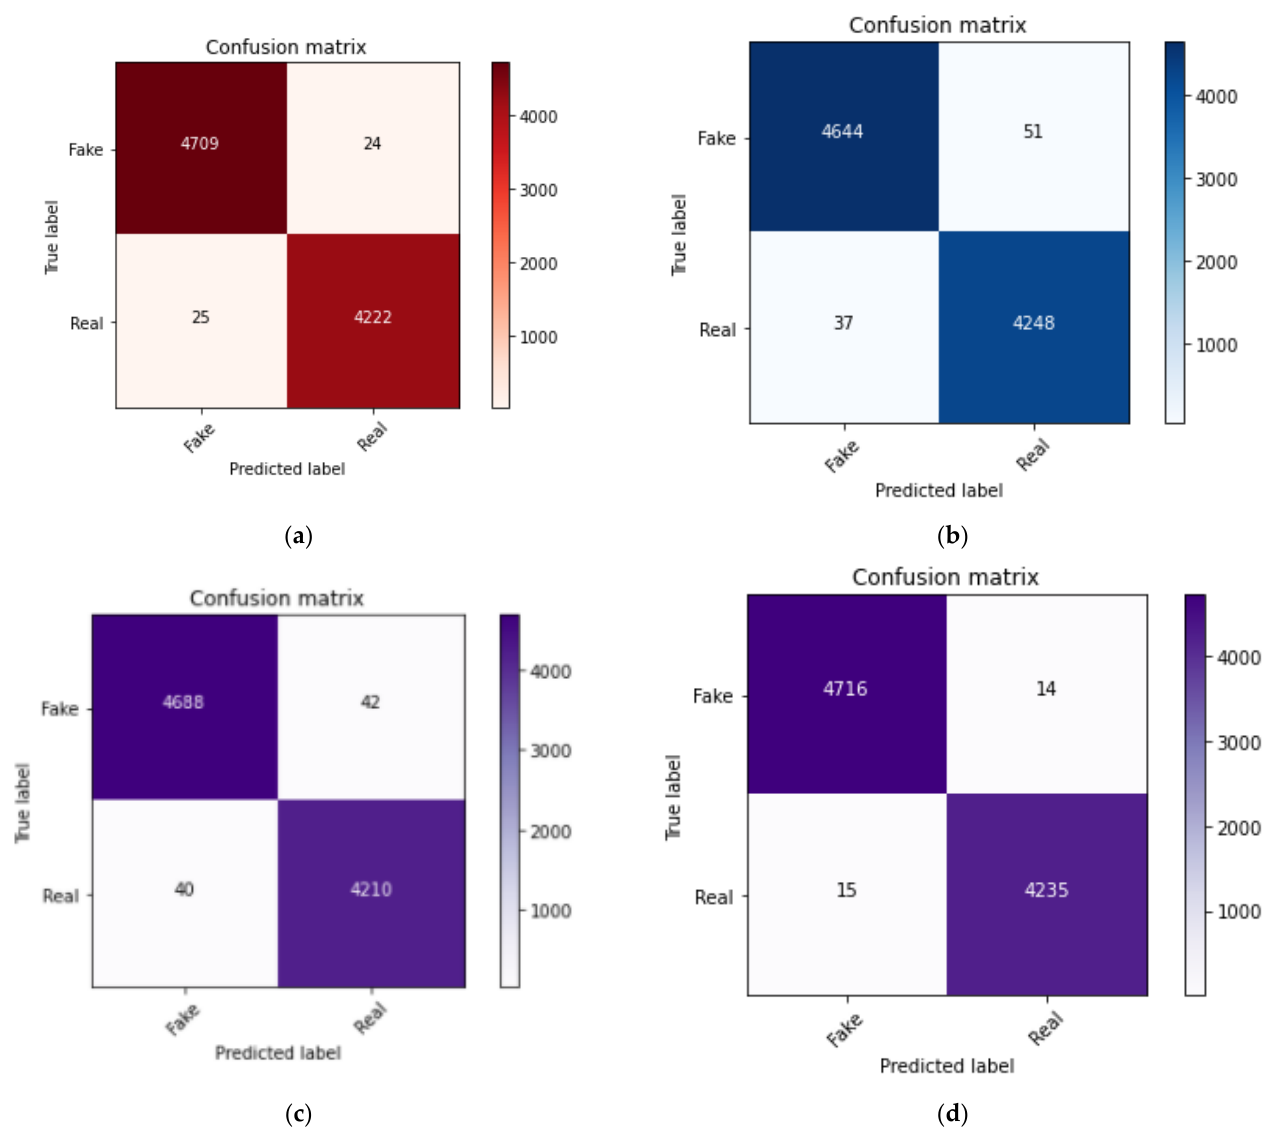
Figure 10. Confusion Matrix of true and predicted fake and real datasets: ( a ) confusion matrix of the TF-IDF vectorizer model; ( b ) confusion matrix of the logistic regression model; ( c ) confusion matrix of the random forest model; ( d ) confusion matrix of the decision tree model.